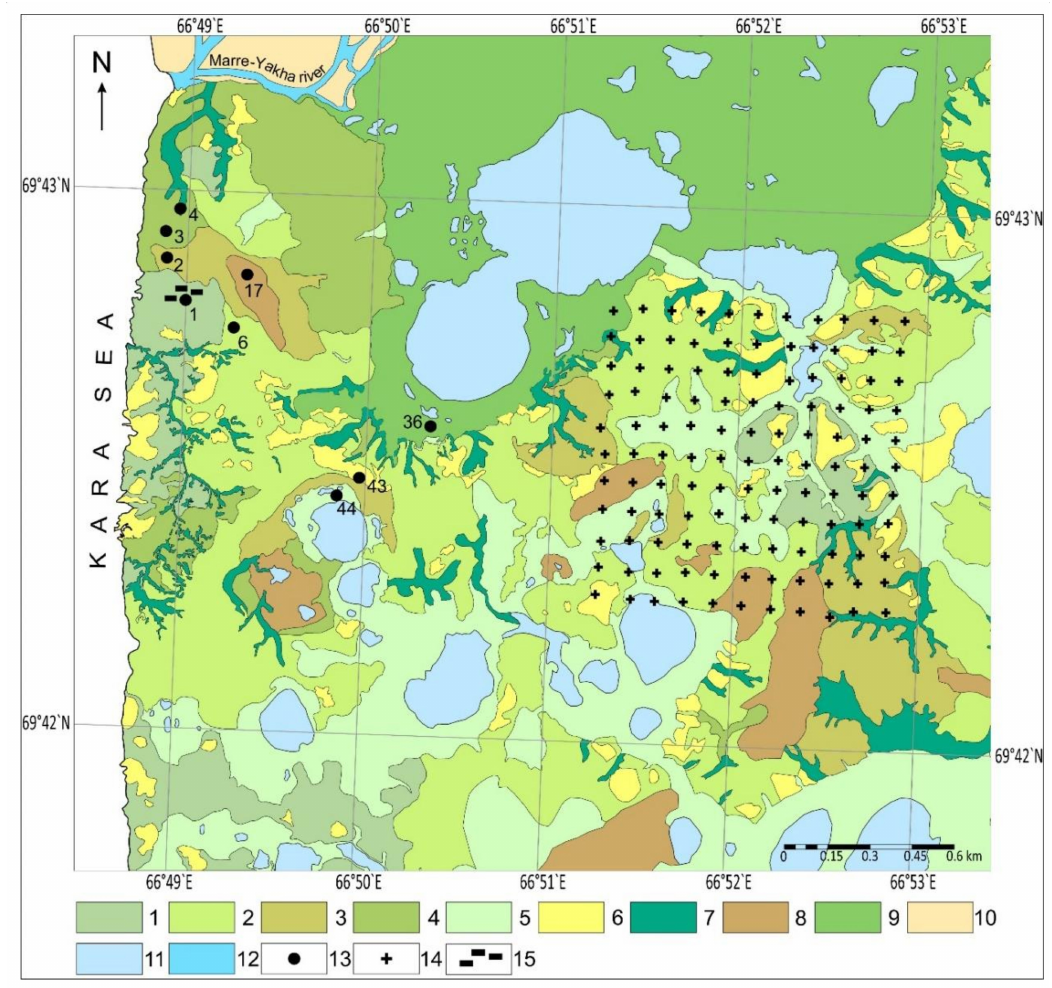
Figure 4. Landscape map of the Marre-Sale study area. 1–9: dominant landscapes. 1—Moist tundra (MT), 2—well-drained tundra (WDT), 3—polygonal tundra (PT), 4—saturated tundra (ST), 5—lake basins (LB), 6—sand fields (SF), 7—water tracks and gullies (WT), 8—peatlands (PL), 9—peat bogs (PB), 10—sand point bars of the Marre-Yakha River, 11—lakes, 12—Marre-Yakha River, 13—study sites, 14—CALM grid, 15—Marre-Sale weather